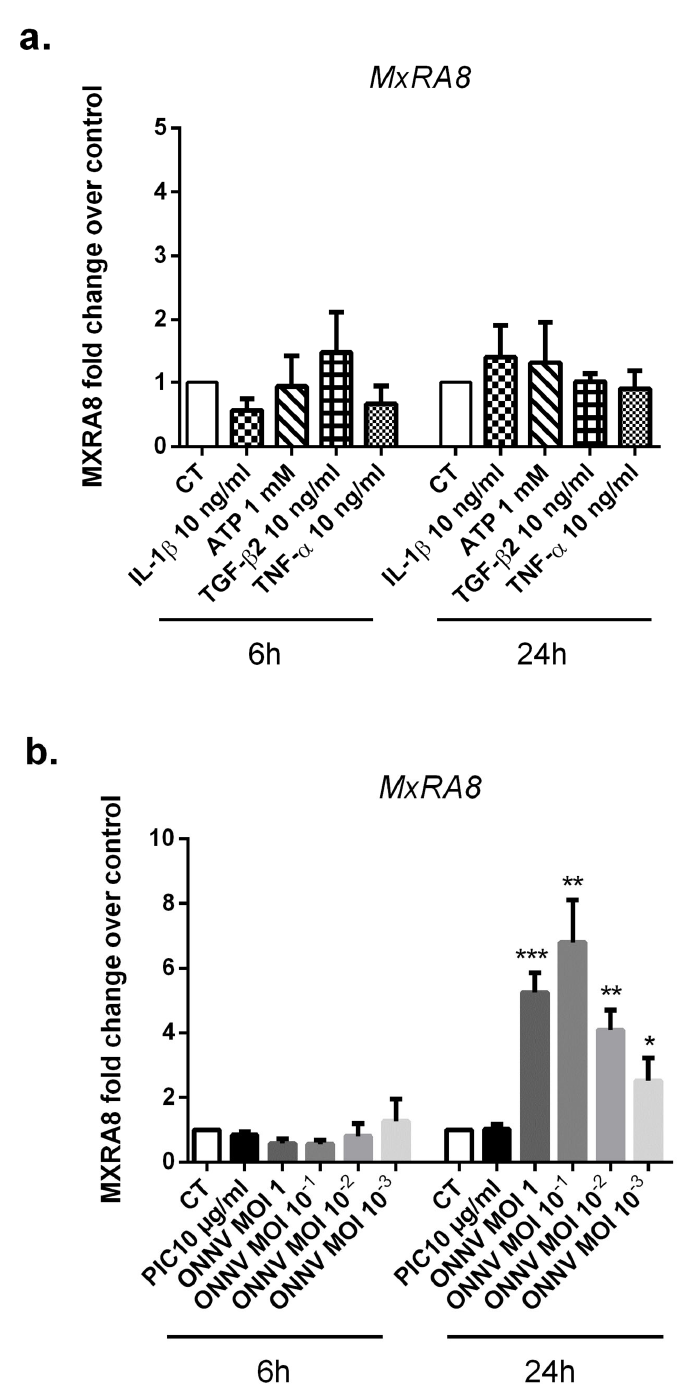
Figure 1. MxRA8 alphavirus entry receptor is upregulated in ONNV-infected SC. ( a ) MXRA8 mRNA levels from SC exposed to stimulatory treatments (IL-1 β 10 ng/mL, TNF- α 10 ng/mL, TGF- β 2 10 ng/mL, and ATP 1 mM) or ( b ) infected with ONNV (from MOI 10 − 3 to 1) or stimulated with PIC 10 µ g/mL for 6 h and 24 h as assessed by qRT-PCR. All experiments were done in triplicates. Results are expressed as mean ± SEM and presented as a normalized fold increase vs. control (CT). * p -values ≤ 0.05, ** p -values ≤ 0.01, and *** p -values ≤ 0.001 represent significant differences from controls by one-way ANOVA followed by the Bonferroni’s test